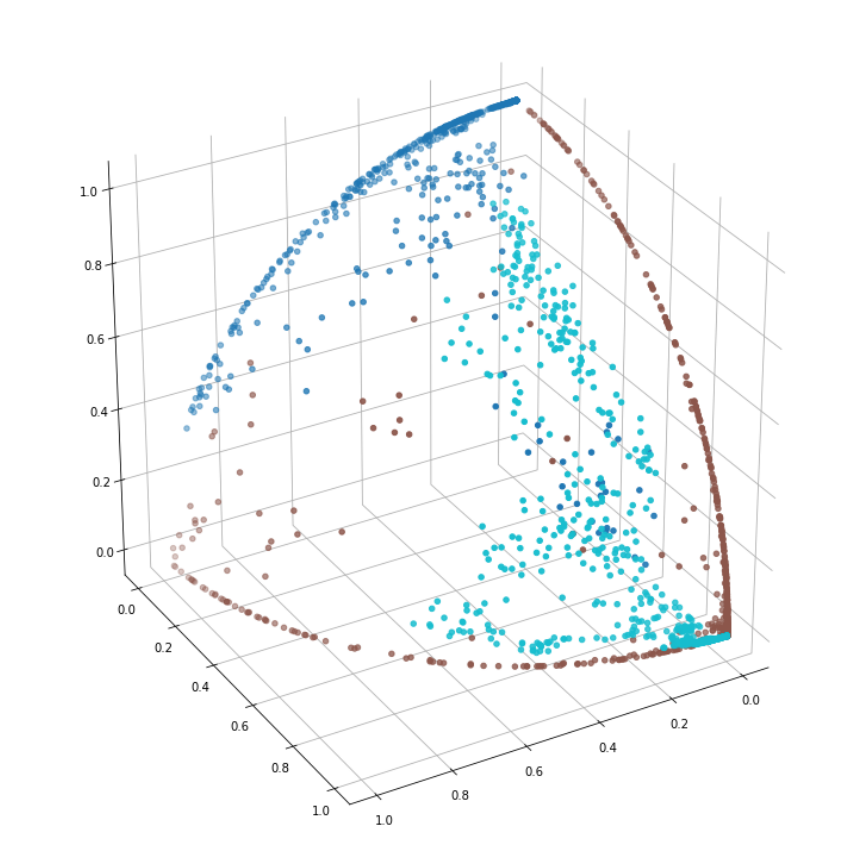
Figure E.1. Three simulated trajectories of probability vectors on a sphere. Each color signifies a trajectory simulated using a specific σ in the random-walk structure described in Section 2.3. Here, three trajectories started at the same point exhibit different progressive structures: stable (dark blue), chaotic and clustering (light blue), and sharp transition